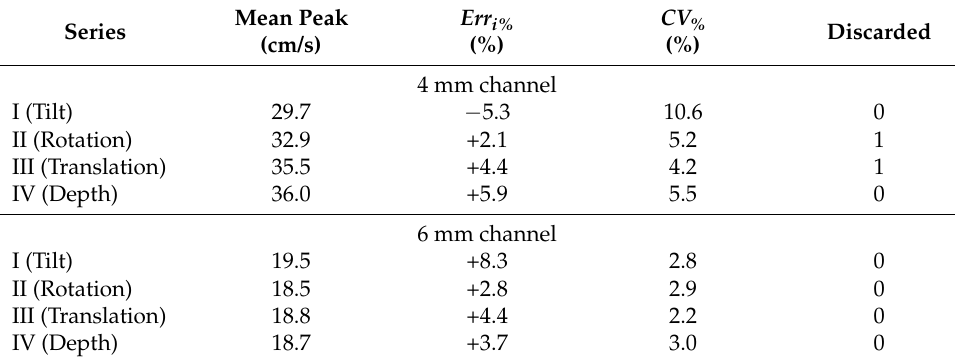
Table 6. Velocity error and